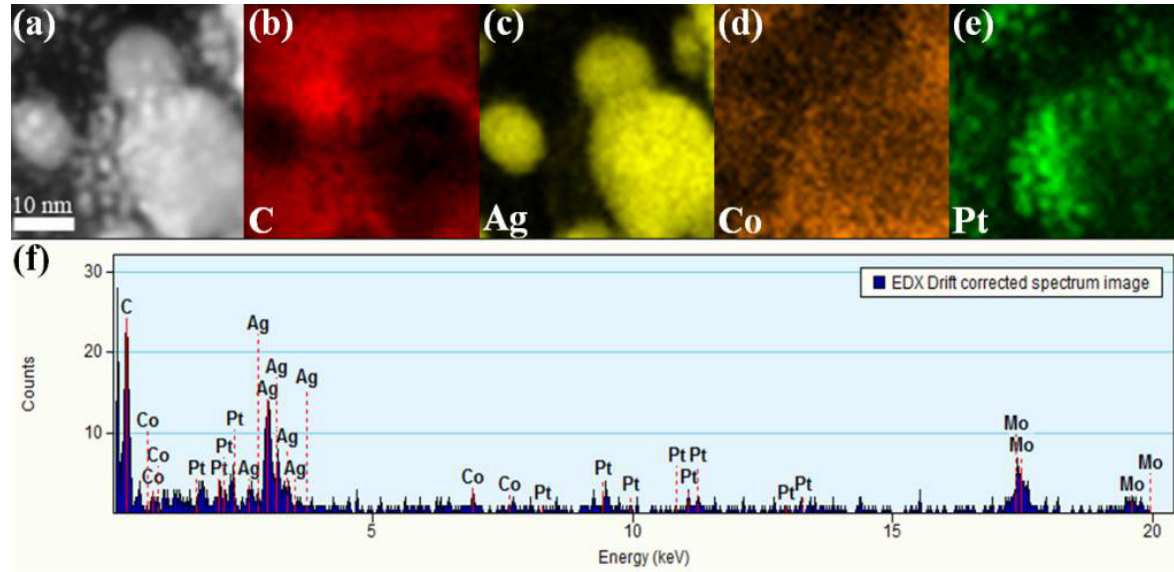
Figure 5. ( a ) HAADF-STEM image, ( b – e ) EDS mapping, and ( f ) EDX spectrum of rGO/CoPt/Ag.